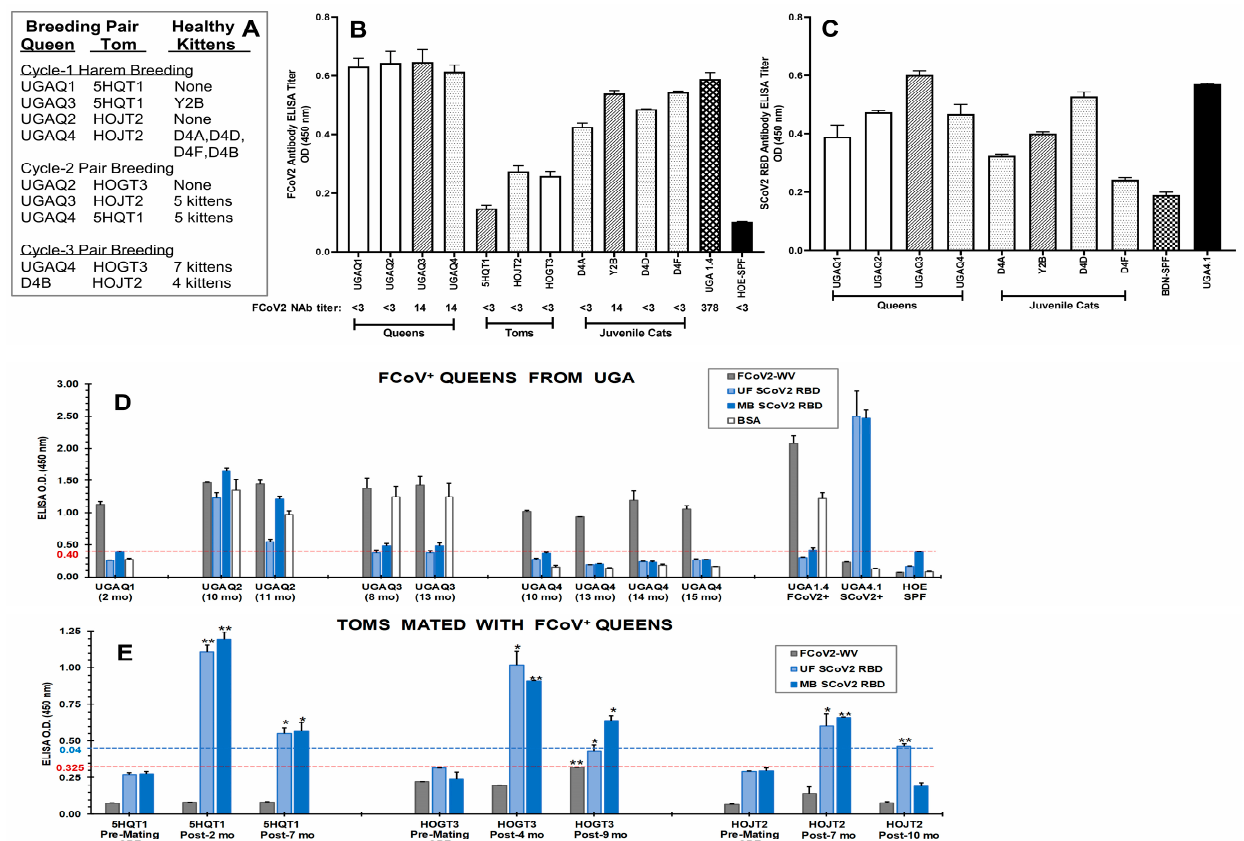
Figure 1. Serum Ab reactivity of the FCoV-positive cats to FCoV2 whole-virus and SCoV2 RBD antigens by ELISA. Four queens (UGAQ1, UGAQ2, UGAQ3, and UGAQ4) were mated at UF with three SPF toms (5HQT1, HOJT2, and HOGT3). In the fi rst harem breeding cycle ( A ), only two of the four queens (UGAQ3 and UGAQ4) successfully mated with two di ff erent toms (5HQT1 and HOJT2) and gave birth to ki tt ens. Queen UGAQ3 mated with 5HQT1 and gave birth to Y2B ( A ), and their bars are represented with slashes ( B , C ). Queen UGAQ4 mated with HOJT2 and gave birth to D4A, D4D, D4F, and D4B ( A ). The bars of D4A, D4D, and D4F are represented with small dots ( B , C ). At the time of fi rst blood collection, these ki tt ens were juvenile cats at 16 weeks old for D4A, D4D, and D4F and 12 weeks old for Y2B ( A ). The open bars are the two queens UGAQ1 and UGAQ2 ( B , C ) that were also harem mated with toms 5HQT1 and HOJT2, respectively. They did not give birth to ki tt ens in the fi rst mating or in the pair mating for UGAQ2 ( A ). The serum from FCoV2-seropositive cat UGA1.4 ( B ) and SCoV2-inoculated cat UGA4.1 ( C ) was used as positive control serum. The serum from SPF cats HOE ( B ) and BDN ( C ) were used as negative control serum. The FCoV2 NAb titers shown below the cat identi fi cation code ( B ) were those measured at fi rst arrival for queens and post- fi rst mating for toms. FCoV2 NAb assays were performed thrice for repeatability. The sera from the later timepoints described in Figure 1D,E were tested twice and had no detectable NAbs (data not shown). Additionally, the serum Ab cross-reactivity of four FCoV + queens ( D ) at post-UF arrival in months (mo) and three toms ( E ) at pre-mating and post- fi rst mating with the FCoV + queens was tested by stringent ELISA. Their sera were tested for reactivity to FCoV2-WV (grey bar), SCoV2 UF- RBD (light blue bar), SCoV2 MB-RBD (blue bar), and BSA (white bar). The positive threshold value for Figure 1D is 0.400 O.D., based on the maximum, non-speci fi c binding of the serum from the SPF cat HOE to the antigen, MB SCoV2 RBD. Since the pre-mating serum was collected from the toms when they were still SPF, we used the pre-mating serum from an SPF tom with the highest non- speci fi c reactivity to antigen. The positive threshold value (do tt ed red line) in Figure 1E is set at 0.325 O.D., which is based on the highest reactivity of the pre-mating serum from the SPF tom HOGT3 to the antigen FCoV2-WV. The positive threshold value (do tt ed blue line), which is higher than the pre-serum threshold, is based on the highest non-speci fi c binding of the serum from the SPF cat